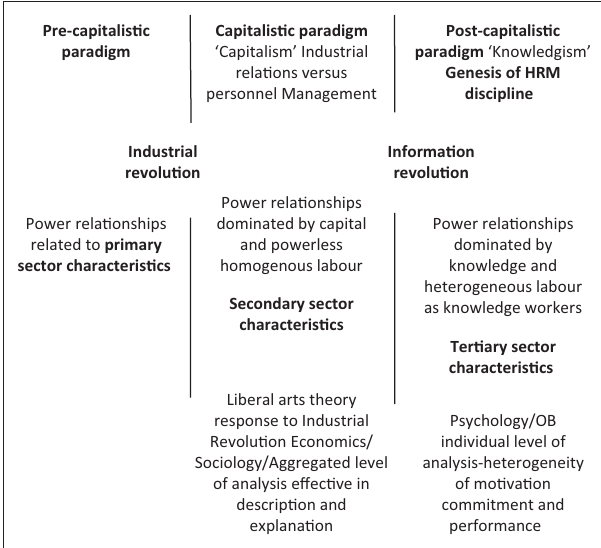
FIGURE 1: Human resource management and its emergence as a post-capitalistic phenomenon.